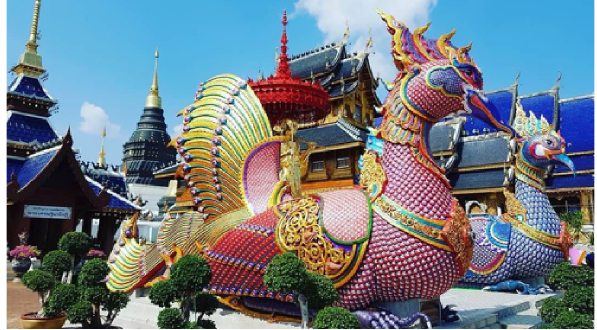
Figure 9. The matrix size of RGB image is 280 × 497 × 3.